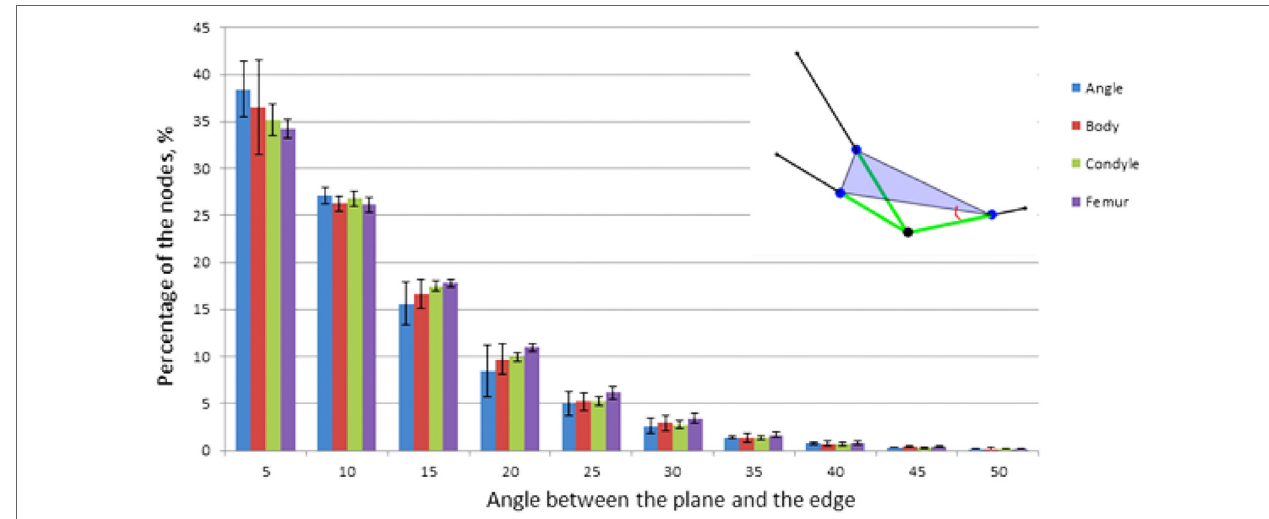
FigUre 9 | Planarity of 3-N nodes. Percentage of nodes is plotted versus the angle between one of the edges and the plane. Insert: the measured angle, red; auxiliary plane, purple; edges,